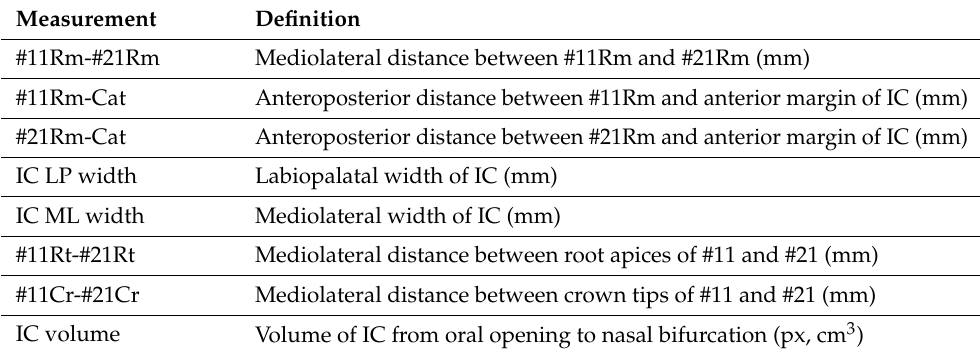
Table 1. Measurements used in this study (summary of abbreviations).